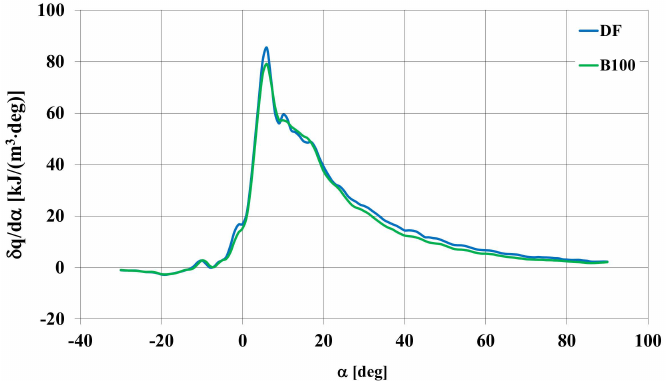
Figure 17. Process of the rate of unit heat release in relation to piston displacement- δ q/d α in the domain of crankshaft rotation angle-at the rotation speed of 1600 min − 1 for the engine powered with fuels DF diesel or B100.